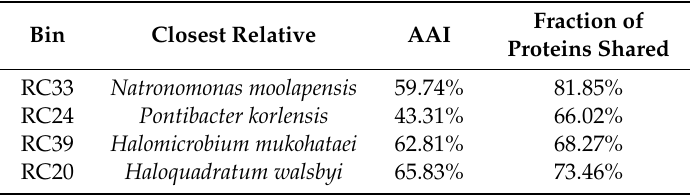
Table 4. Amino acid identity (AAI) of the four genomic bins obtained. The closest relative of each organism, along with its AAI and fraction of proteins shared, are